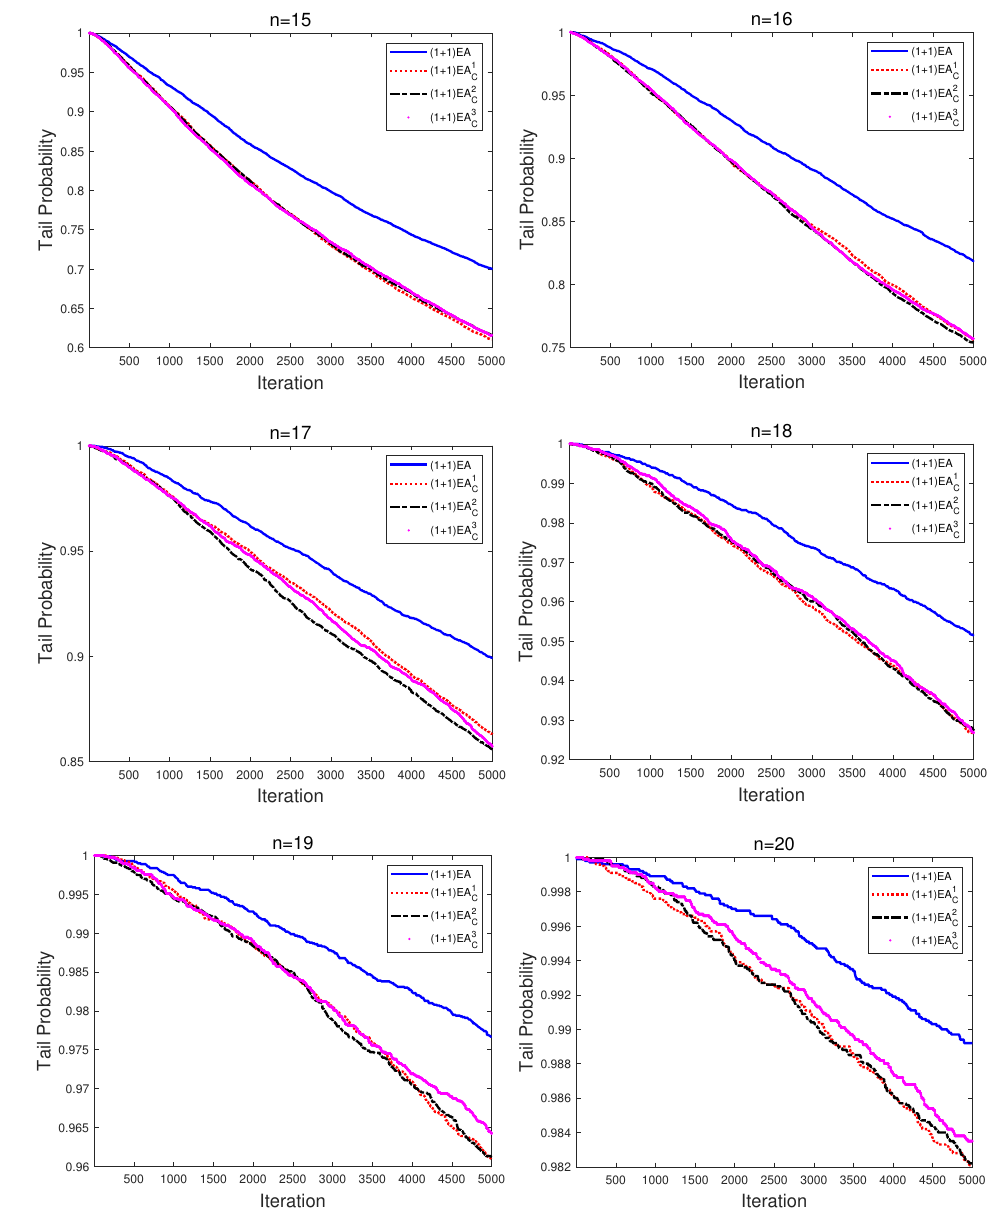
Figure 3. Numerical comparison on tail probabilities (TPs) of adaptive ( 1 + 1 ) EA and ( 1 + 1 ) EA C applied to the Deceptive problem, where n is the problem dimension. ( 1 + 1 ) EA 1 ( 1 + 1 ) EA 3 are three variants of ( 1 + 1 ) EA C with q m initialized as 1 √ C